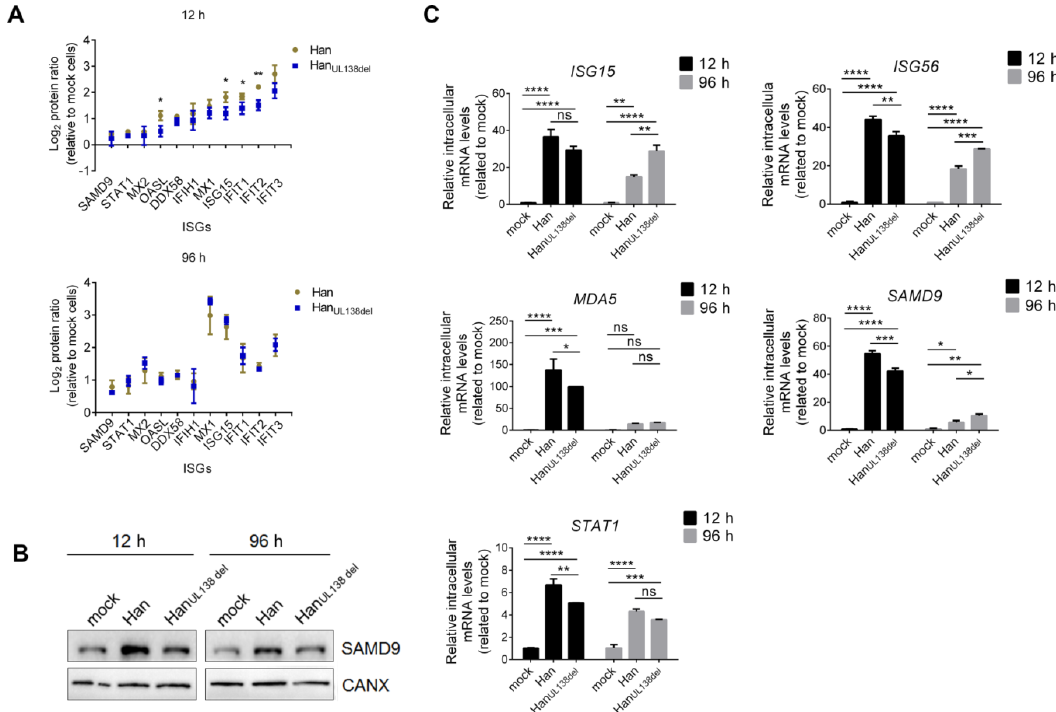
Figure 4. Differential regulation of the innate immune response by Han and Han UL138del at early stage post infection. ( A ) Differential expression of ISGs in Han- and Han UL138del -infected MRC5 cells at 12 h p.i. or 96 h p.i.. Y-axis: protein ratios quantified by mass spectrometry (relative to mock-treated cells). ( B ) Western blot analysis of SAMD9 levels in Han- and Han UL138del -infected MRC5 cells at 12 h p.i. or 96 h p.i.. SAMD9 was selected as a representative ISG. ( C ) Quantitative RT-PCR analysis of selected ISGs in Han and Han UL138del infected MRC5 cells at 12 h p.i. or 96 h p.i.. ISG15, ISG56, MDA5, SAMD9 and STAT1 were selected as representative ISGs. H: h p.i.. Three replicates were performed, and results are shown as mean ± SD. *p < 0.05; **p < 0.01; ***p < 0.001; ****p < 0.0001; ns, no significance.